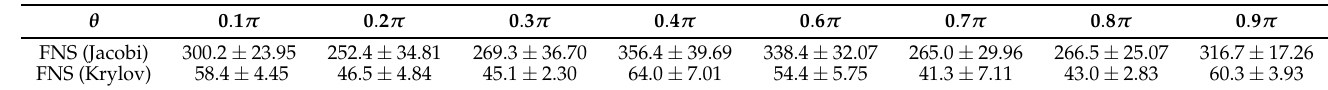
Table 2. Mean and standard deviation of the number of iterations required to achieve the stopping criterion over all tests for Equation (13) case